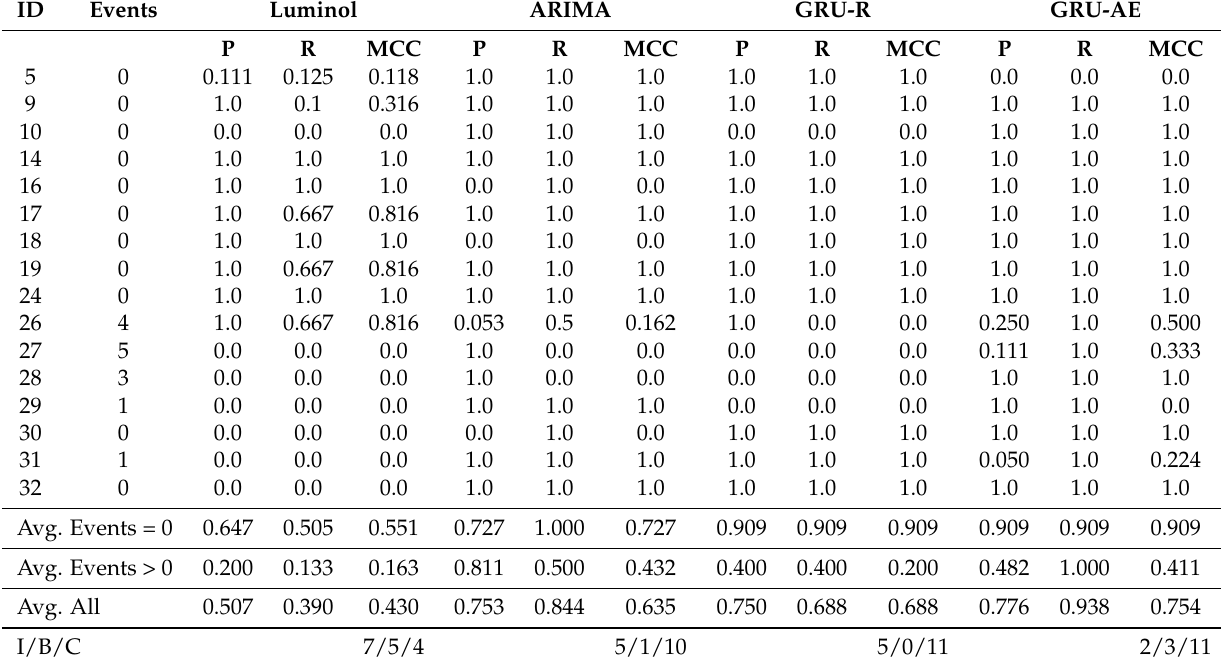
Table 2. Table of results for the grid search-optimised implementation of LinkedIn’s anomaly detection library (Luminol), the grid search-optimised autoregression regression, and PSO-optimised threshold-based anomaly detection of Mahalanobis distance produced by a GRU-based autoencoder. The events column lists how many times the respiratory disease prevalence increases from 0 within the batch, P denotes the precision, and R is the recall of the model. These results are from the test data O t . The final I/B/C row indicates the number of folds that were Incorrect ( MCC = 0.0), Between (0.0 < MCC < 1.0), or Correct ( MCC =